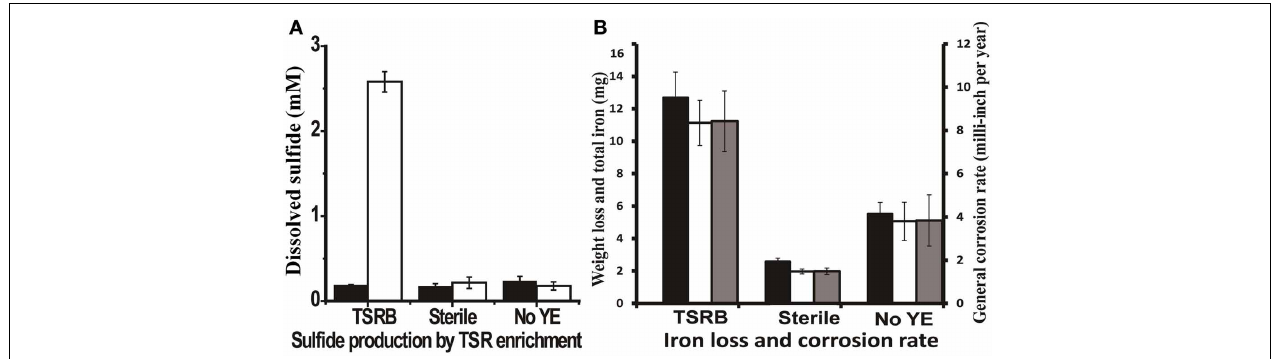
FIGURE 3 | Sulfide production and corrosive activities of thiosulfate-reducing enrichments. (A) Dissolved sulfide accumulation in the medium after 14 days incubation. The black bars represent the dissolved sulfide at zero time, and the clear bars represent dissolved sulfide at the end point of experiment. (B) Weight loss and total iron released from coupon in the cultures after 14 days incubation. The black